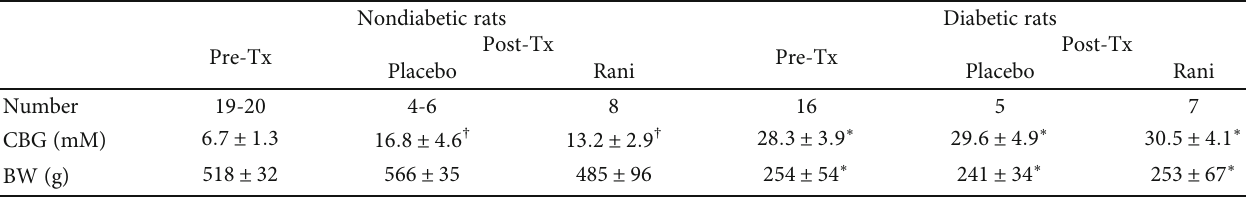
Table 1: Body weight and blood glucose levels in nondiabetic and diabetic rats. Nondiabetic rats Diabetic